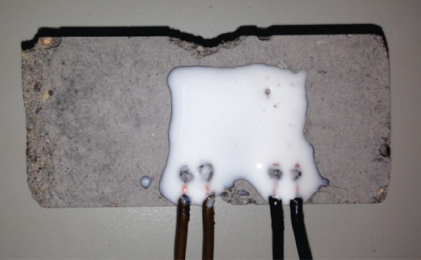
Figure 3: Adhesion and capsulation of the strain gauge.